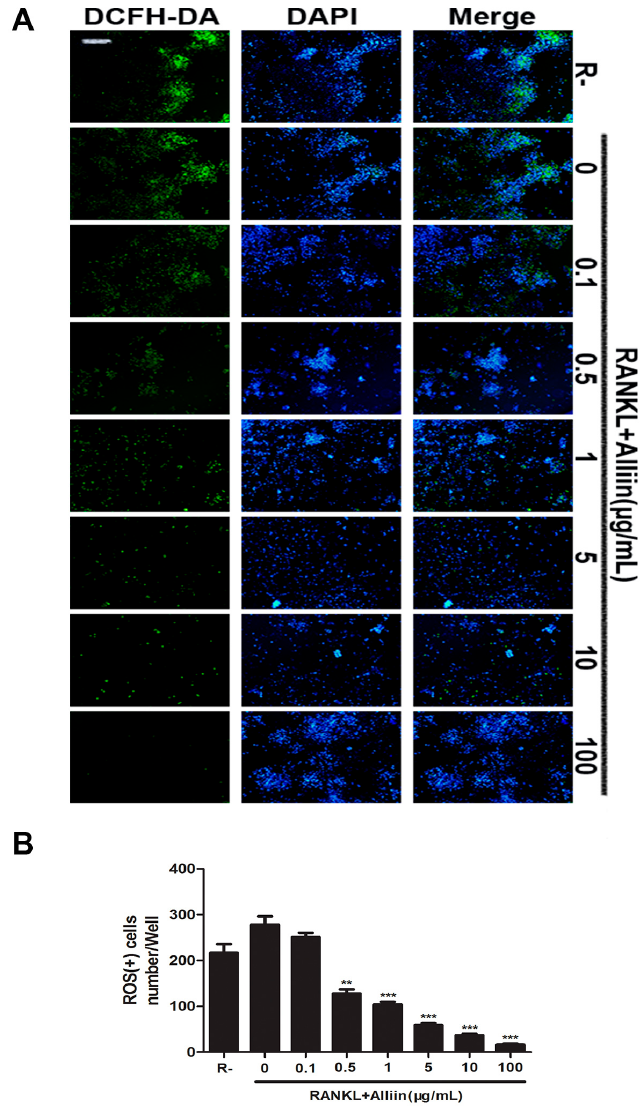
Figure 5. Alliin scavenged ROS production in a dose-dependent way. ( A ) ROS detection by fluorescent probe DCFH-DA. Scale bar represents 200 µm; and ( B ) quantitative analysis of ROS (+) cells in each well (96-well plate). Data in the figures represent the mean ± SD. ** ( p -value < 0.01) and *** ( p -value < 0.001) based on one way ANOVA.